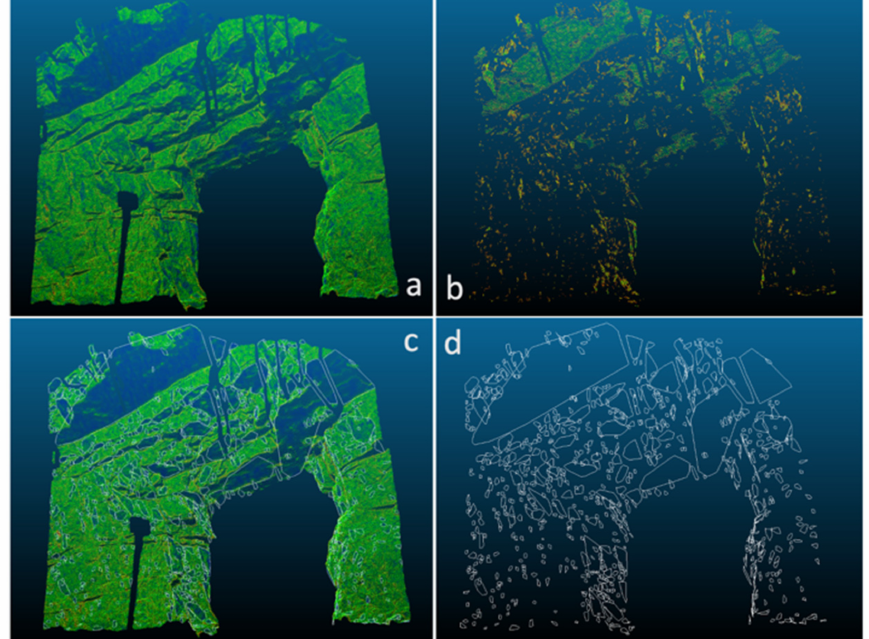
Figure 9. Extraction of discontinuity planes from point cloud TLS. ( a ) Step1: identify the flat sectors (blue areas) and germination of discontinuities on an organized point cloud. ( b ) Step2: progressive germination by adding co-planar points with the initial nucleus. ( c , d ) Definition of the 3D polygons that delimit the discontinuity planes